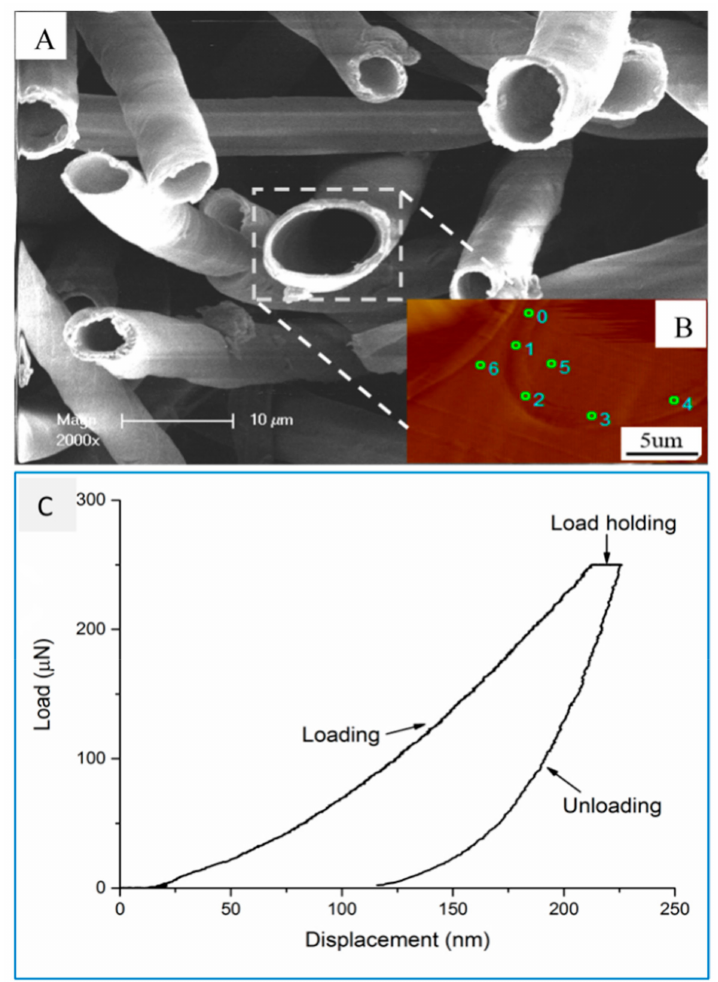
Figure 11. SEM image of the cross-section of poplar catkin fibers ( A ), inserted nano-indentation image of indent positions for the PCF cell wall by nanoindentation ( B ), and a typical nanoindentation load-displacement curve ( C